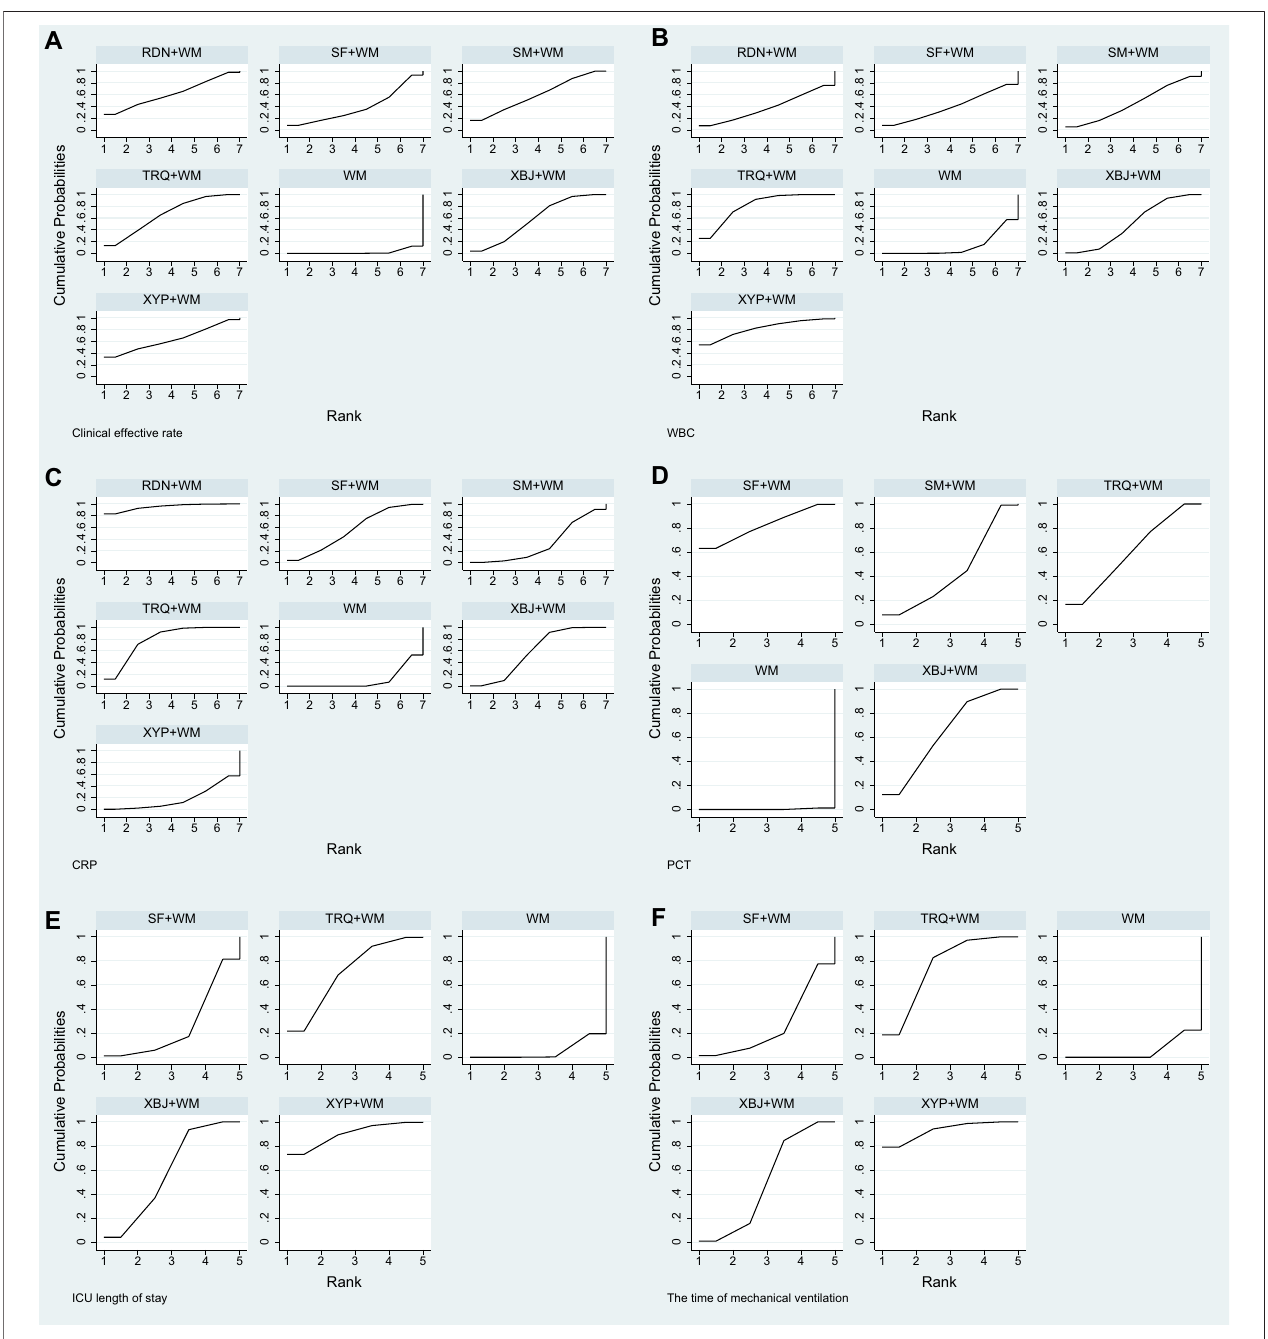
FIGURE 5 | Plot of surface under the cumulative ranking curve (SUCRA) for all different outcomes. (A) Clinical effective rate; (B) the level of WBC; (C) the level of CRP; (D) the level of PCT; (E) ICU length of stay; and (F) the time of mechanical ventilation.